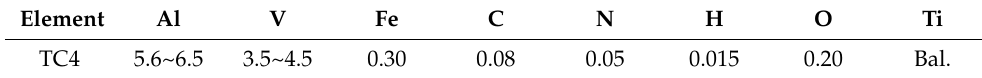
Table 1. Chemical compositions of TC4 (wt%).